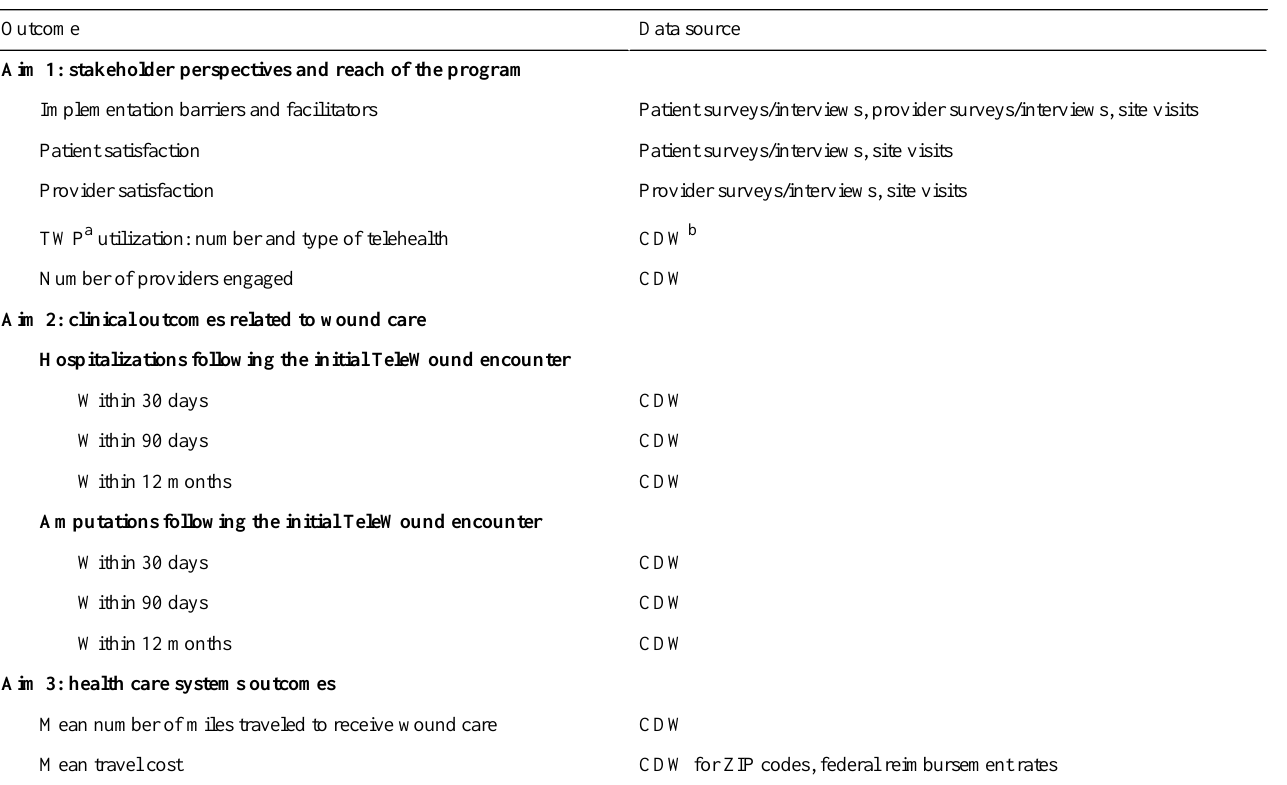
Table 1. Evaluation outcomes and data